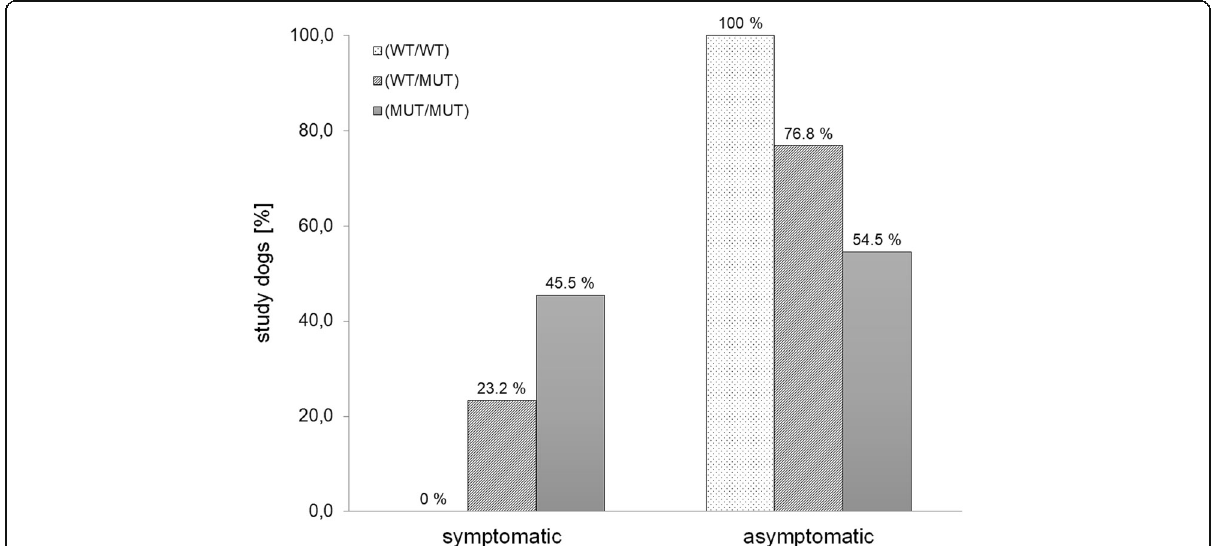
Fig. 4 Distribution of von Willebrand type I symptoms in correlation with the corresponding genotype. Percentages of dogs with (symptomatic) or without symptoms (asymptomatic) were determined for each genotype group. 23.2% of heterozygotes (WT/MUT) showed bleeding symptoms compared to 45.5% of homozygous dogs (MUT/MUT). No symptoms were reported for wild-type (WT/WT) dogs without the mutation. Based on